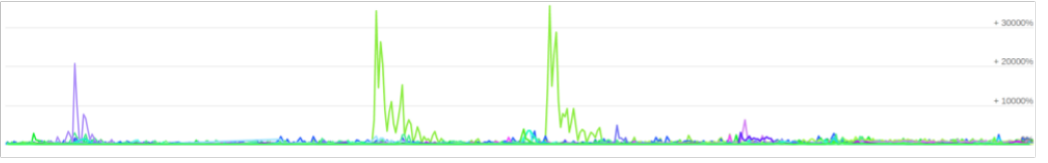
Figure 3. Trendline showing distributions of the top hashtags in the Twitter dataset. #citizenscience—purple, #data—green.